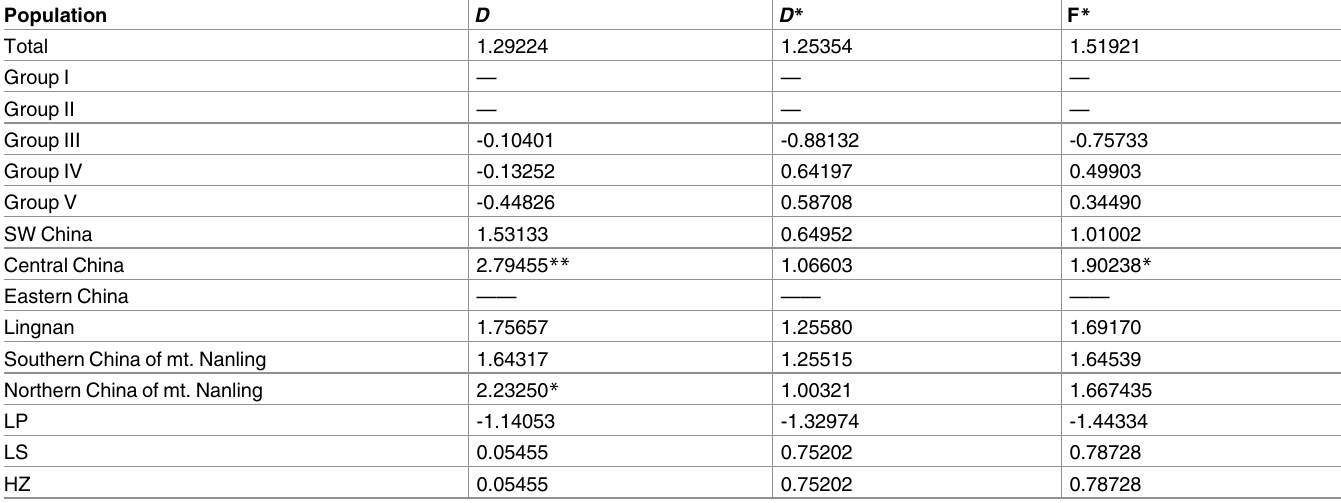
Table 4. Neutral tests of all Bretschneidera sinensis populations and geographic